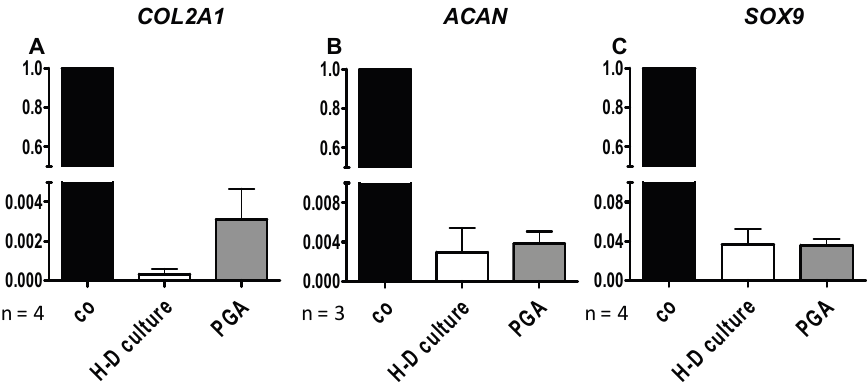
Figure 8. Relative gene expression of chondrogenic differentiated MSCs in H-D culture and on PGA scaffolds compared with freshly isolated, non-cultured articular chondrocytes (co). MSCs (passage 4–6) underwent chondrogenic differentiation for 14 days. ( A ) COL2A1 ; ( B ) ACAN ; ( C ) SOX9 . n = 3–4 independent experiments with cells of different donors were performed. Data was analyzed using the Wilcoxon signed rank test, Kruskal Wallis and Dunns post test.